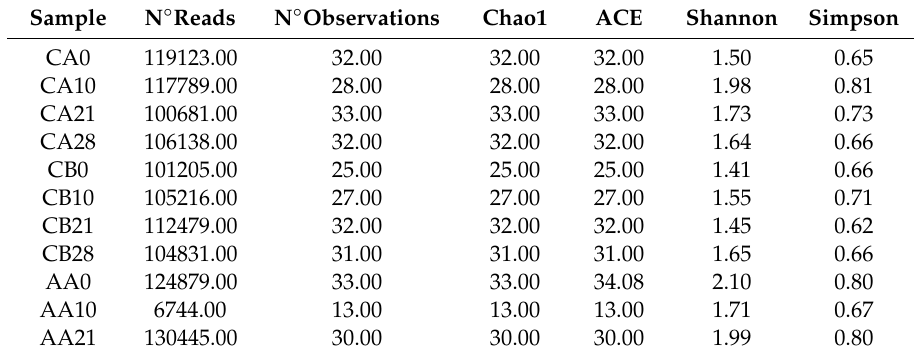
Table 1. N ◦ of reads and alpha diversity indexes at the genus level of the Paipa cheese samples.